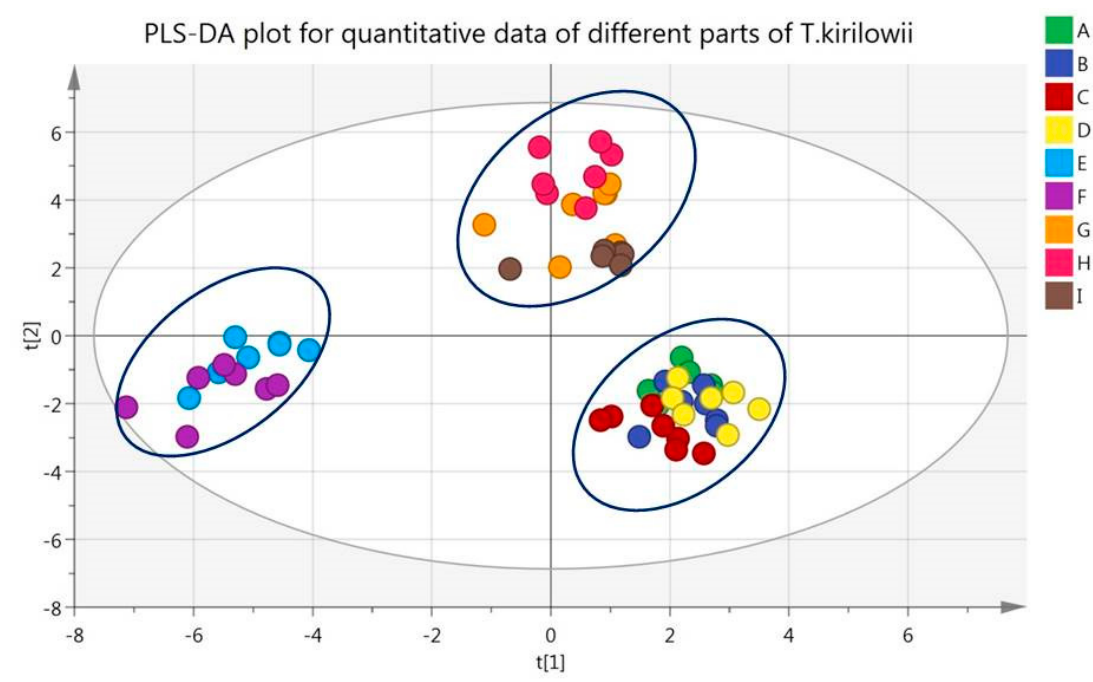
Figure 4. PLS-DA plot of T. kirilowii samples. main root ( A ), lateral root ( B ), lateral root bark ( C ), main root bark ( D ), stem ( E ), leaf ( F ), pericarp ( G ), fruit pulp ( H ) and seed kernels ( I ). Table 4. The possible characteristic components (VIP > 1) in different organs of T. kirilowii (%).